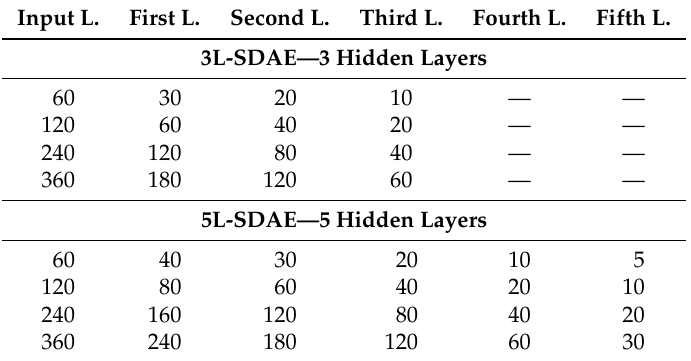
Table 1. Per-layer hidden units in the tested 3L-SDAE and 5L-SDAE architectures. Input L.